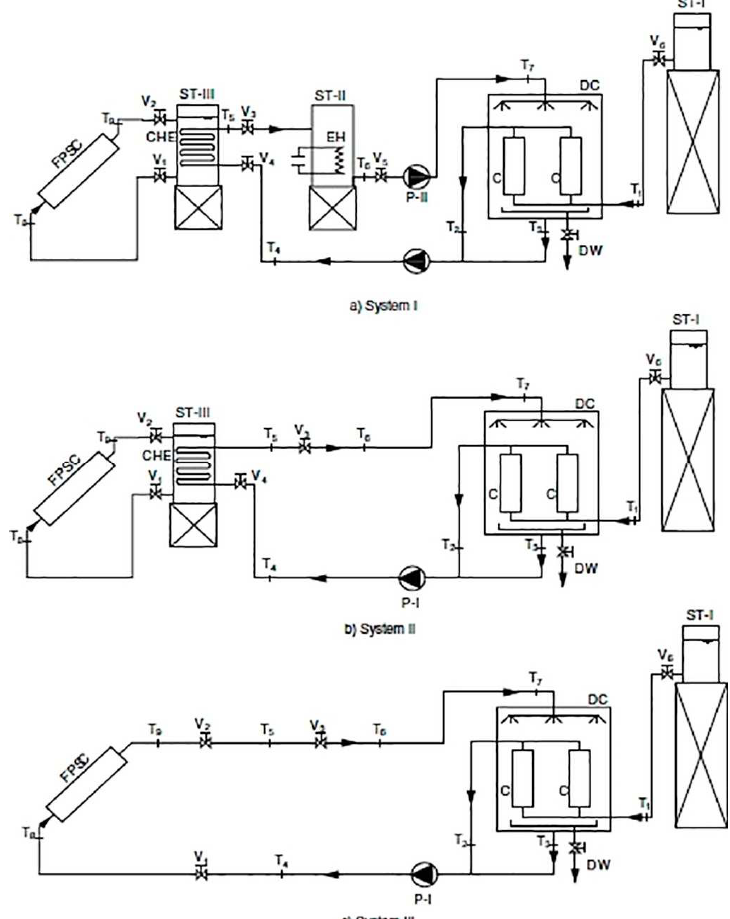
Figure 8. A study of solar saline water desalination systems. Reproduced with permission from Adel M. Abdel Dayem, M. Fatouh, Desalination Journal, published by Elsevier, 2009 [99].